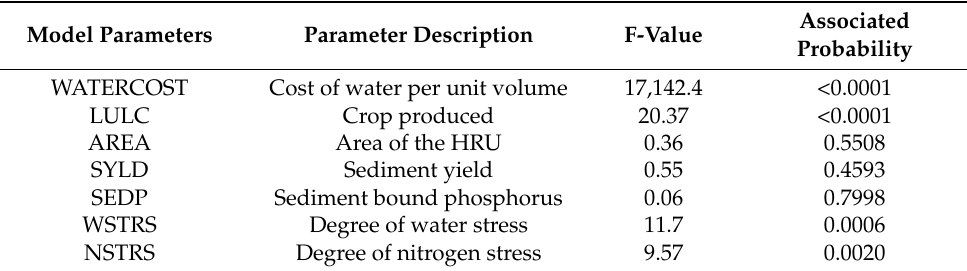
Table 3. Results of analysis of variance (ANOVA) in determining the factors that influence annual net benefit